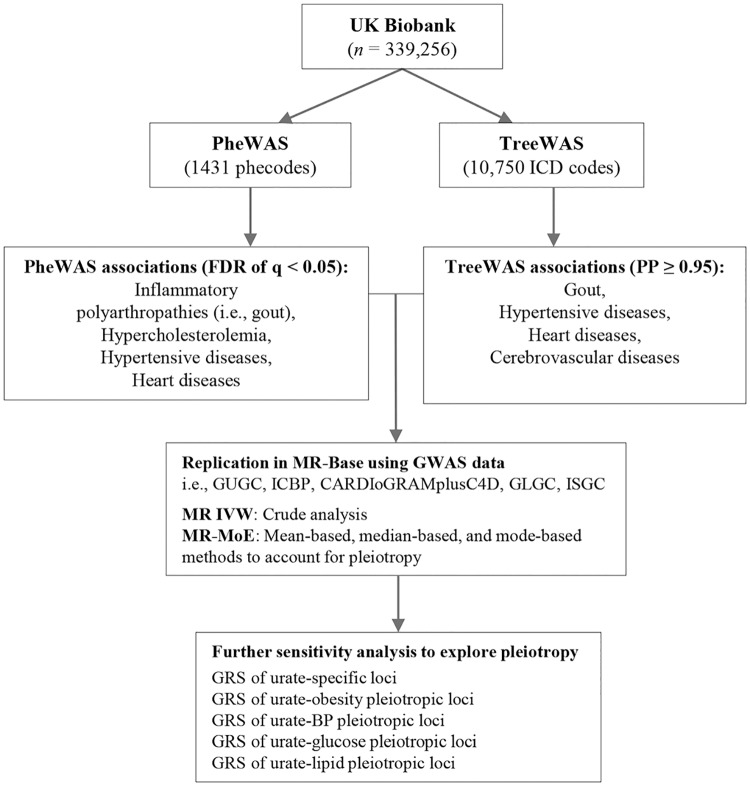
Schematic representation of the study design.BP, blood pressure; CARDIoGRAMplusC4D, Coronary ARtery DIsease Genome wide Replication and Meta-analysis (CARDIoGRAM) plus The Coronary Artery Disease (C4D) Genetics consortium; FDR, false discovery rate; GLGC, Global Lipids Genetic Consortium; GRS, polygenic risk score; GUGC, Global Urate Genetic Consortium; GWAS, genome-wide association study; ICBP, International Consortium for Blood Pressure; ISGC, Ischaemic stroke Genetic Consortium; MR IVW, inverse variance weighted mendelian randomization; MR-MoE, a mixture-of-experts machine learning framework of mendelian randomization; PheWAS, phenome-wide association study; PP, posterior probability; TreeWAS, tree-structured phenotypic model.